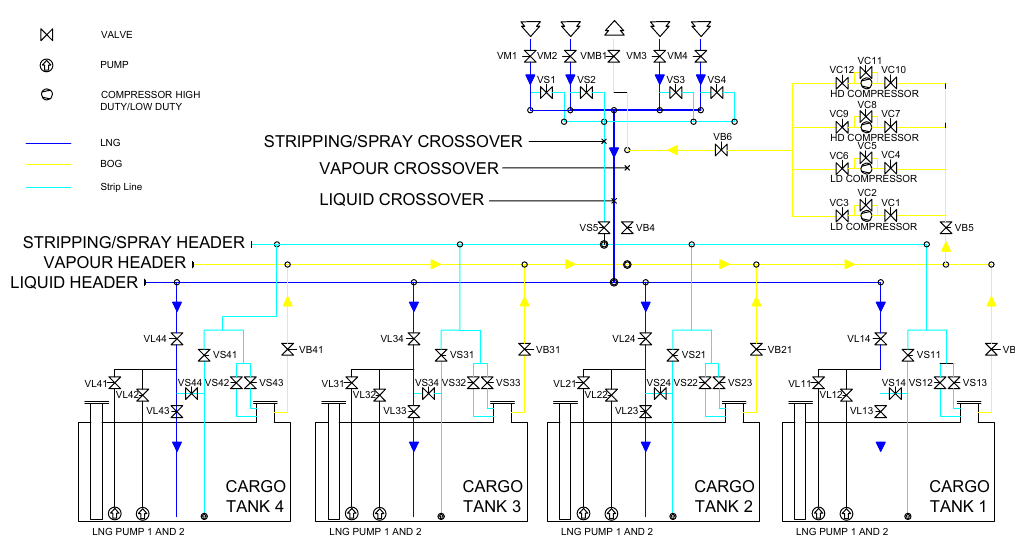
Figure A1. A schematic of the LNGC components used during discharging (authors’ illustration based on relevant technical manuals).